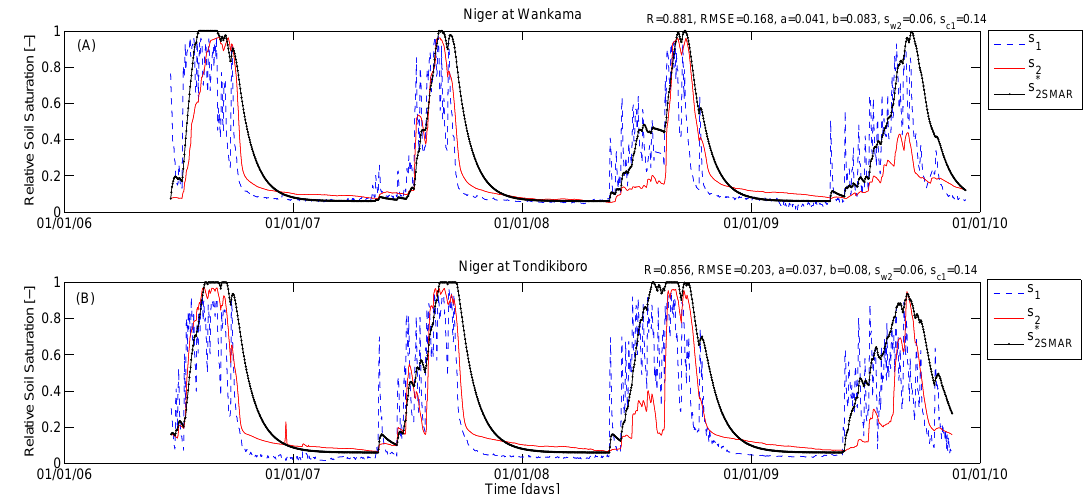
Fig. 6. Comparison between the relative saturation at 5cm ( s 1 ) and the averaged value over 100, 130, and 135cm depth, and the filtered value ( s ∗ – black line) obtained with SMAR for two sites located at Wankama (A) and Tondikiboro (B) , respectively. Results have been 2SMAR obtained assigning parameters based on the physical characteristics of the study